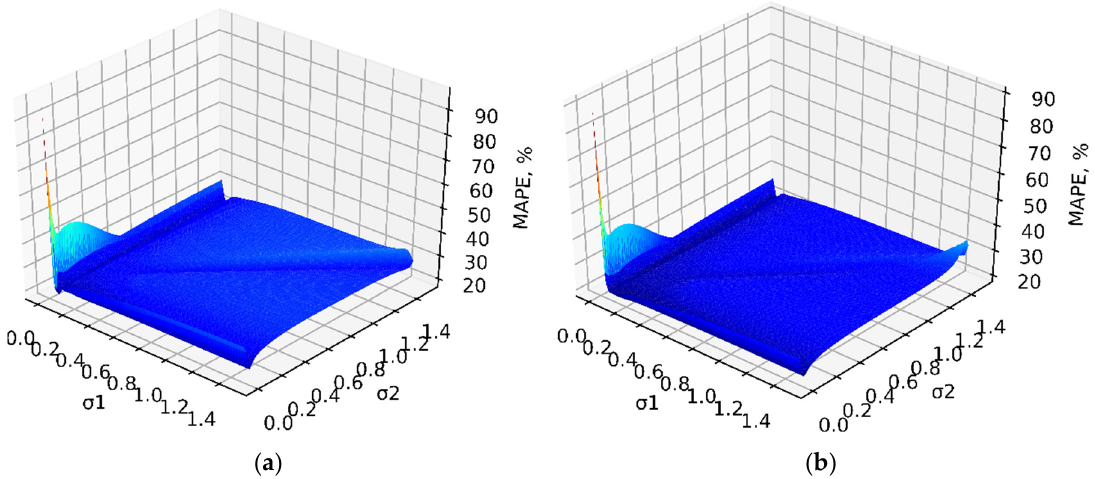
Figure 5. Mean Absolute Percentage Error (MAPE)-values under different combinations of smooth factors σ 1 т a σ 2 of both GRNN ensemble networks: ( a ) in the training mode and ( b ) in the application mode.